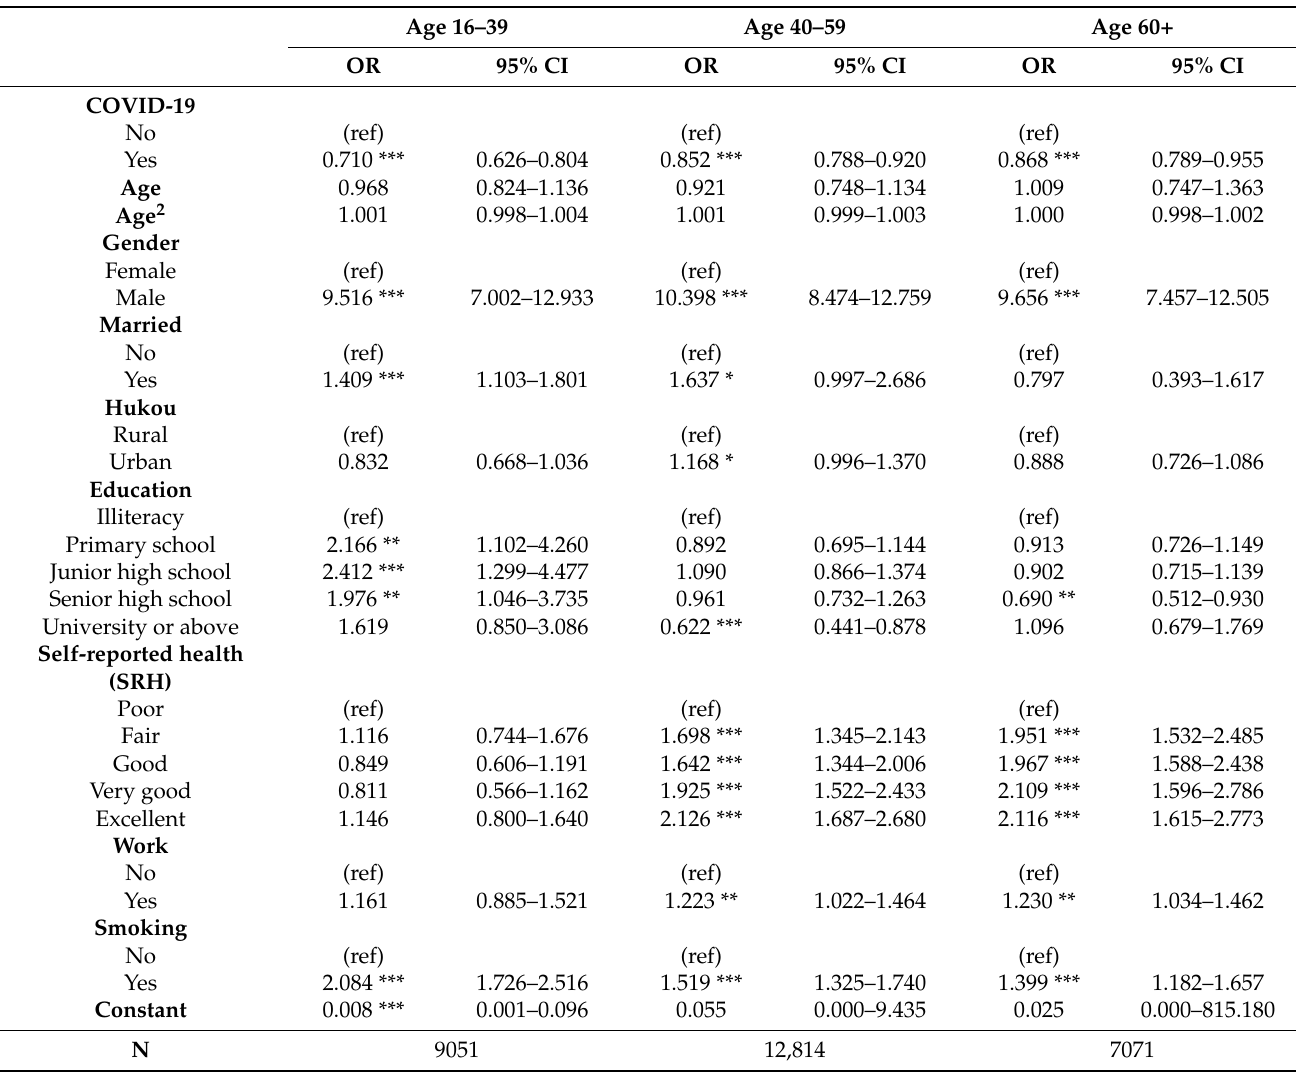
Table 4. Logit regression results for the effects of COVID-19 pandemic on drinking